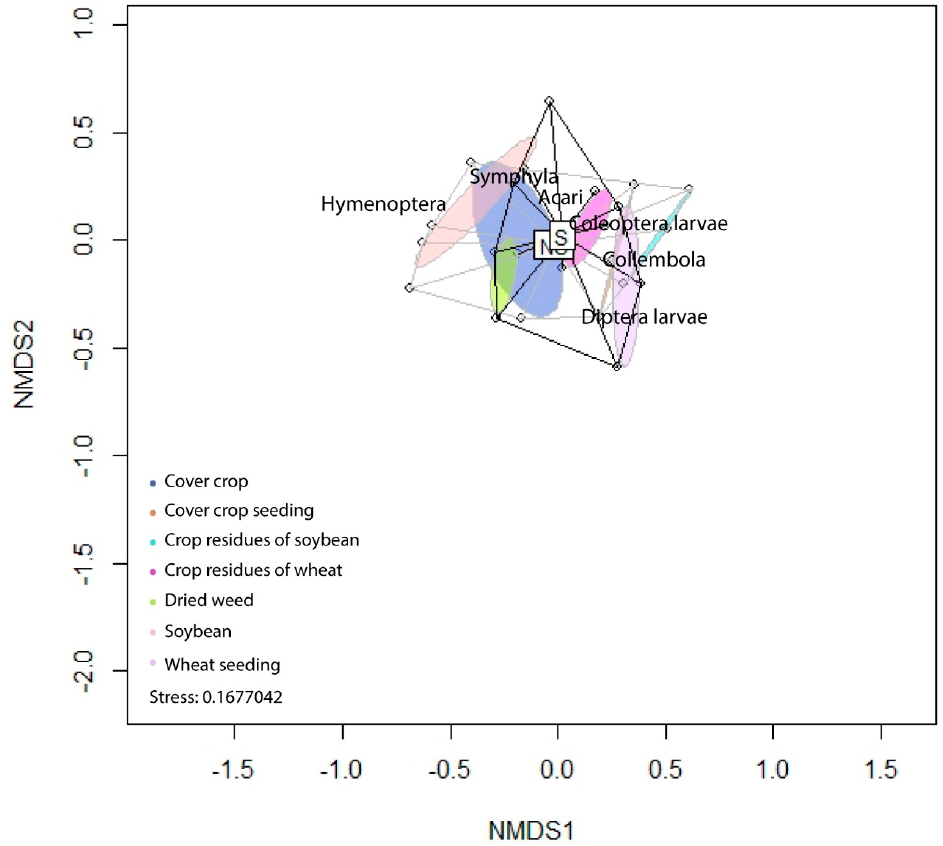
Figure 7. Bray–Curtis based NMDS plot of the arthropod community composition in the Cavallini farm. Points represent samples. “Spider” diagrams connect each point to the belonging irrigation system: NS: no sub-irrigation, in grey, and S: sub-irrigation, in black. Ellipses represent crop variables. To avoid overlapping, only the six more abundant groups were labelled.